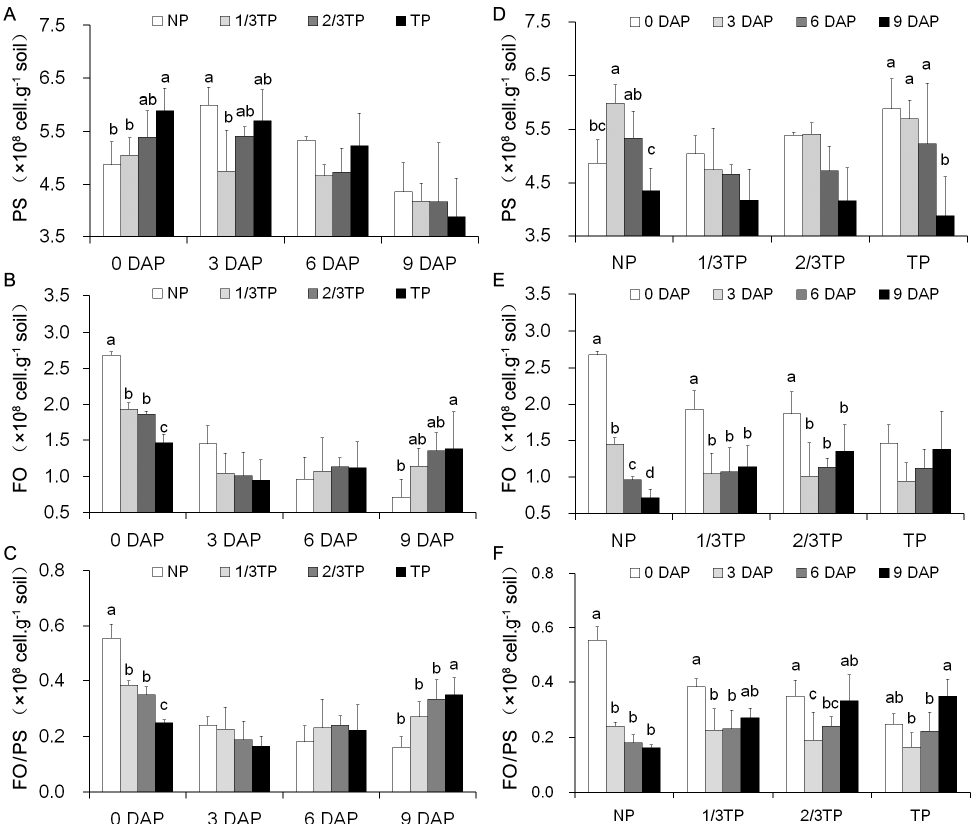
Figure 1. The influences of di ff erent replant disease stress levels on the numbers and ratio of FO to PS in R. glutinosa rhizosphere soils over time. NP, 1 / 3TP, 2 / 3TP and TP are the gradient treatments of replant disease stresses. Four samples in each group are compared with NP ( A – C ) and 0 DAP ( D – F ) respectively, and di ff erent lower-case letters indicate significant di ff erences ( p < 0.05; LSD). Data represented as the mean ± SD ( n = 3). DAP: Days after planting. PS: Pseudomonas spp. FO: Fusarium oxysporum . NP: Soil that was never planted with R. glutinosa for at least 10 years. TP: Soil that was consecutively planted with R. glutinosa in the same soils for three years. Table 1. Pearson correlations among the di ff erent replant disease stress levels and the changes in amplitude of FO / PS and the numbers of PS and FO within 3 DAP. ∆ FO / PS ∆ PS ∆ FO Levels of replant disease stresses 0.7918 ** − 0.5611 Table 2. Pearson correlations among the FO / PS and the numbers of PS and FO within 9 DAP. PS FO FO / PS − 0.2488 0.9208 **